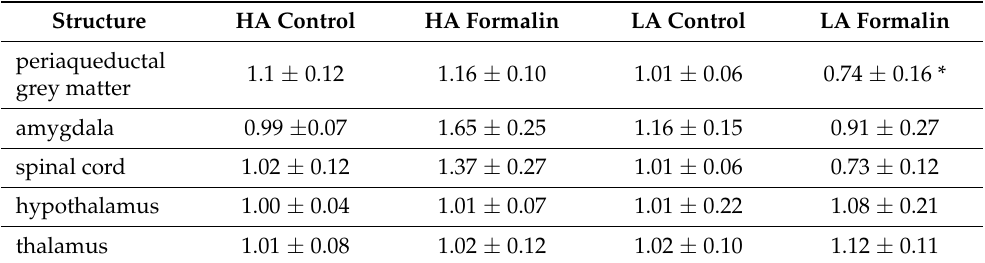
Table 3. Mu opioid receptor 1 (Oprm1) mRNA levels in HA and LA mice in the interphase of the formalin test. Mice were injected with 5% formalin (in PBS) into the dorsal aspect of the hind paw ( n = 4–6). Samples were harvested 15 min post-formalin. Results were analysed within each line with two-way ANOVA followed by Bonferroni’s post-hoc test. Statistical significance was depicted as follows: * p ≤ 0.05 (vs.